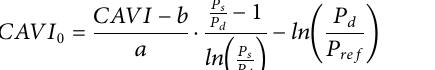
FIGURE 2 | Temporal changes in pulse rate (A) and blood lactate (B) . Filled circles ( abbreviations are the same as in Figure 1 . p p < 0.01 vs. CT; † p < 0.01 vs. baseline. Data are given as mean ± SD.